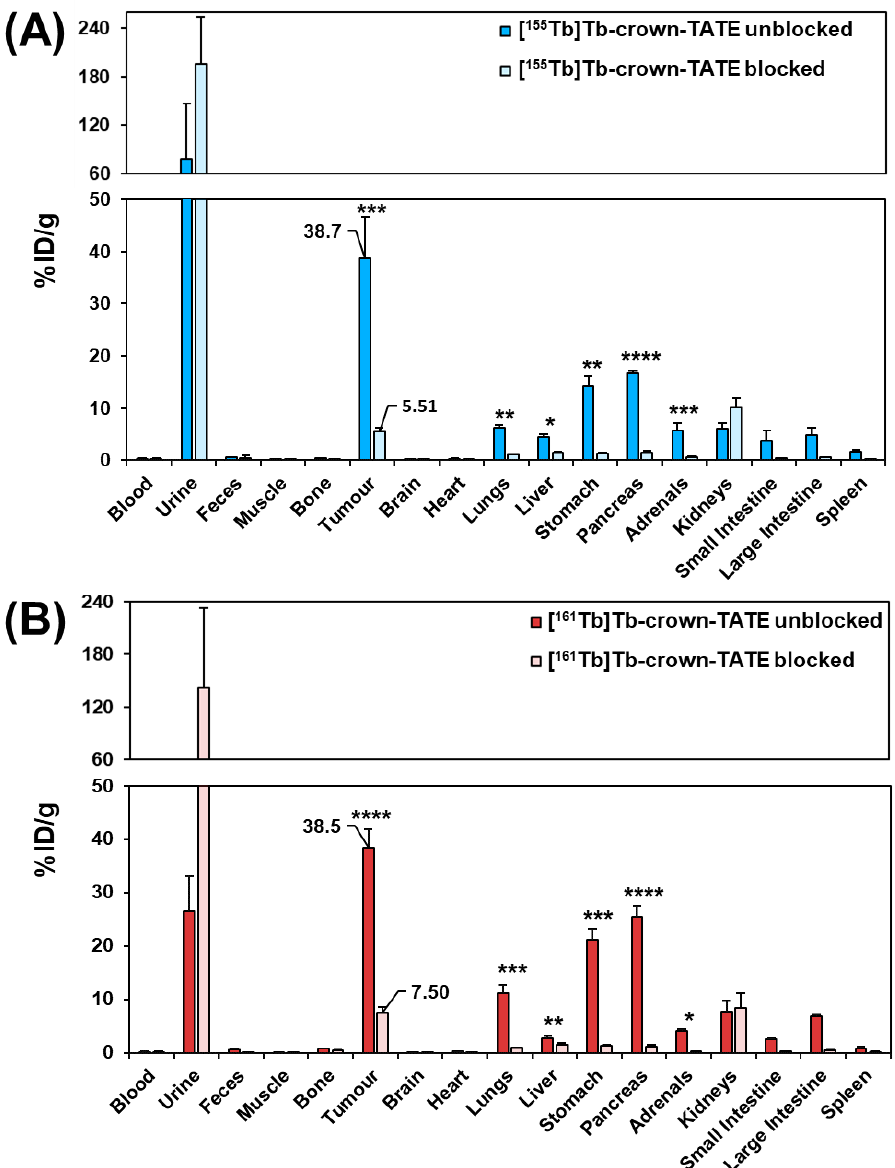
Figure 6. Biodistribution results in male NRG mice bearing AR42J tumours at 2 h post-administration of the following: ( A ) [ 155 Tb]Tb-crown-TATE (~175 kBq, 93 pmol/animal) ( n = 4) (unblocked)